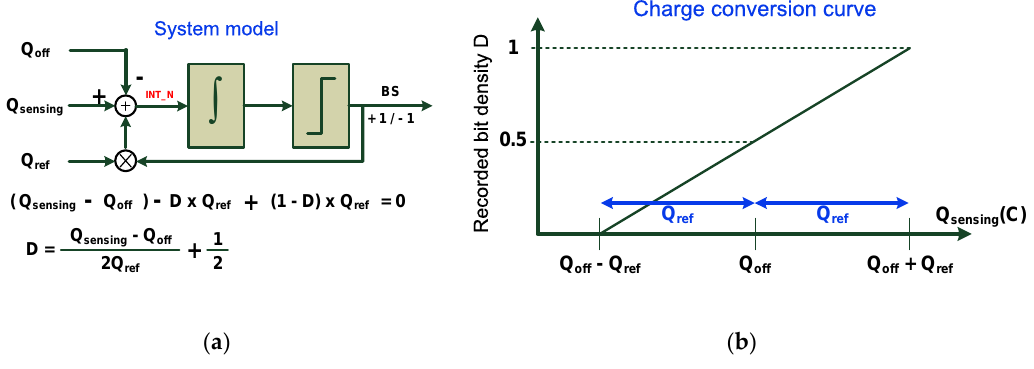
Figure 5. ( a ) System model of the capacitance-to-digital converter (CDC); ( b ) Charge conversion curve of the CDC.